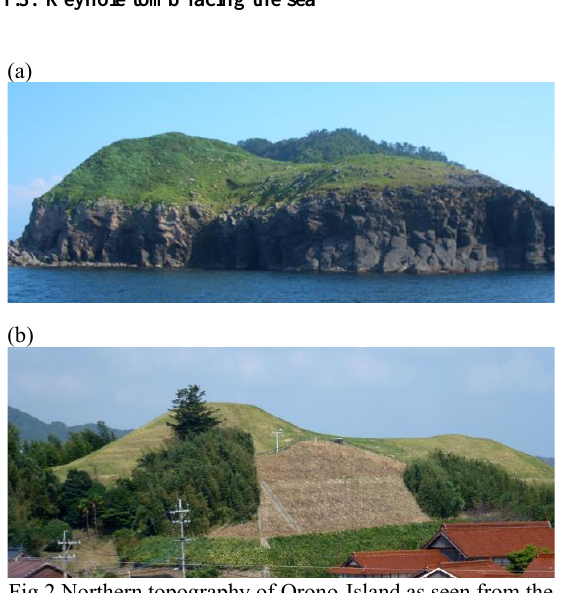
Fig.2 Northern topography of Orono-Island as seen from the sea on the north side and example of early